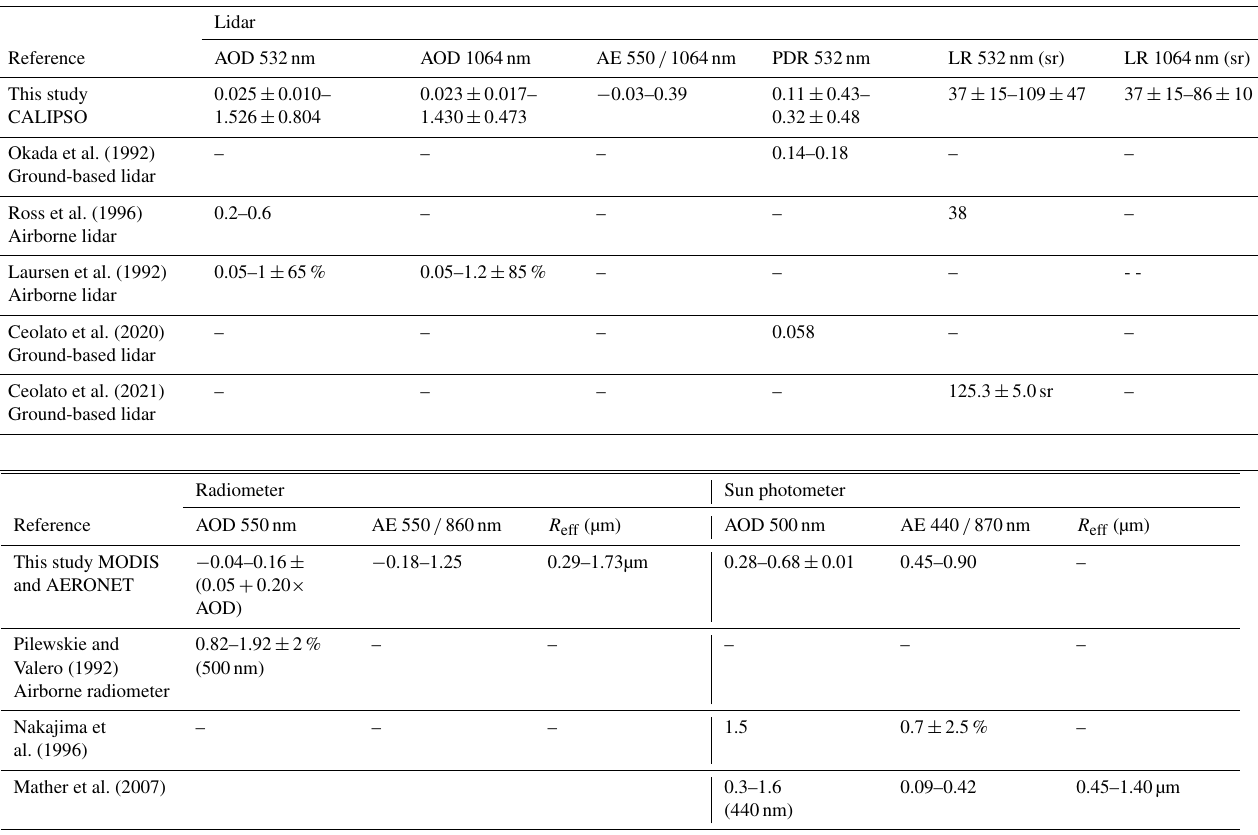
Table 8. Oil smoke optical properties from ground-based and flight measurements along with the scientific reference.